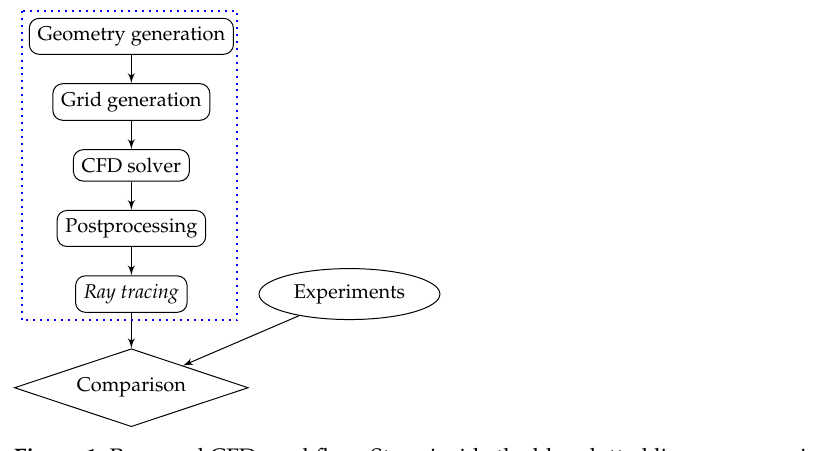
Figure 1. Proposed CFD workflow. Steps inside the blue dotted line are numerical; in a traditional workflow the ray tracing step is